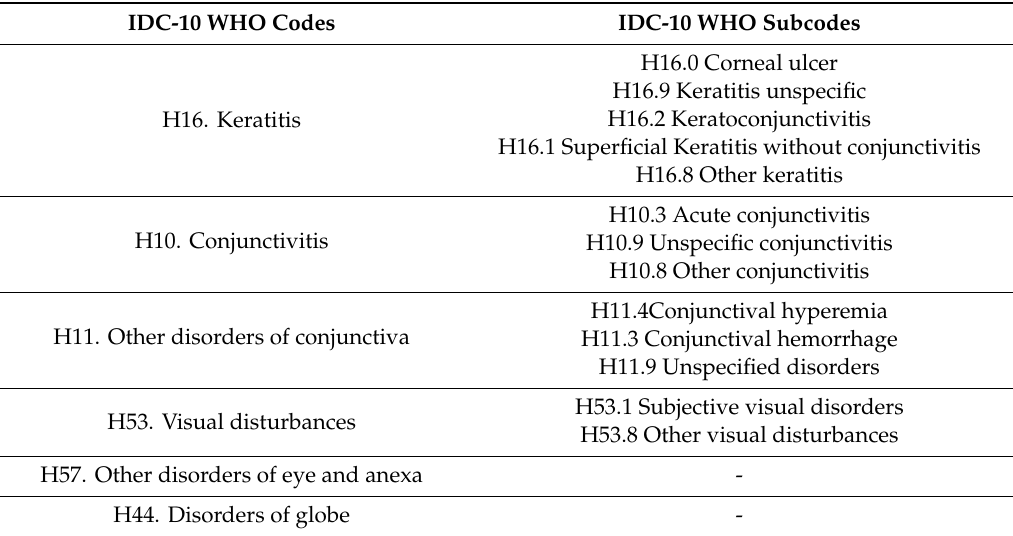
Table 1. The International Classification of Diseases (ICD-10) groups and subgroups classification of work-related eye injury (WREI) by the